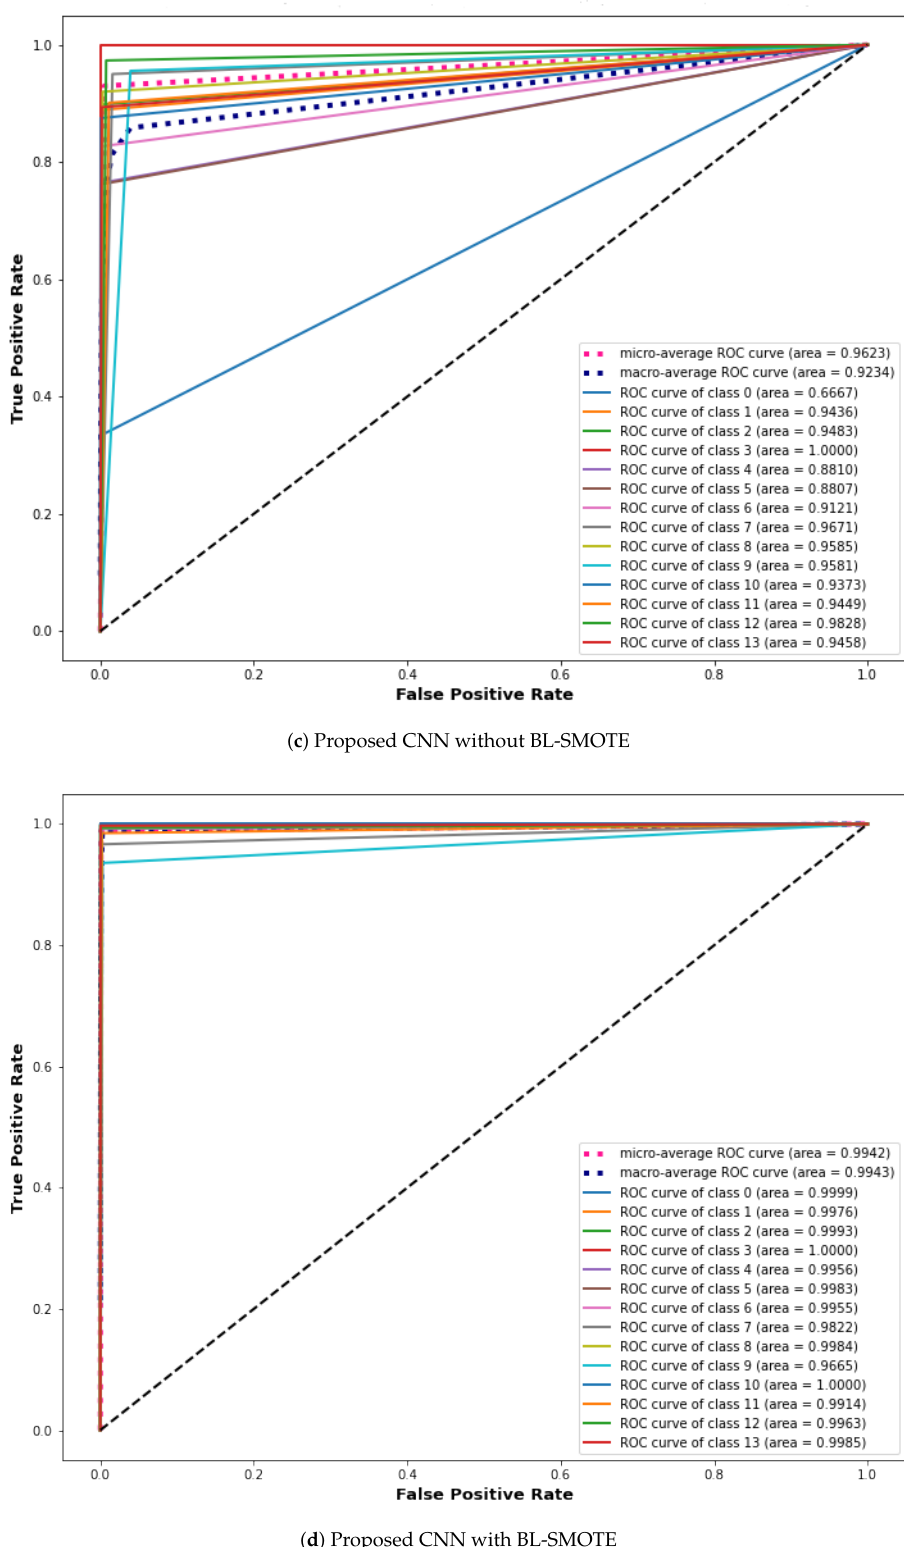
Figure 14. ROC curve analysis using extension receiver of ( a ) VGG16, ( b ) Efficient-Net B0, and ( c , d ) proposed deep CNN model with and without